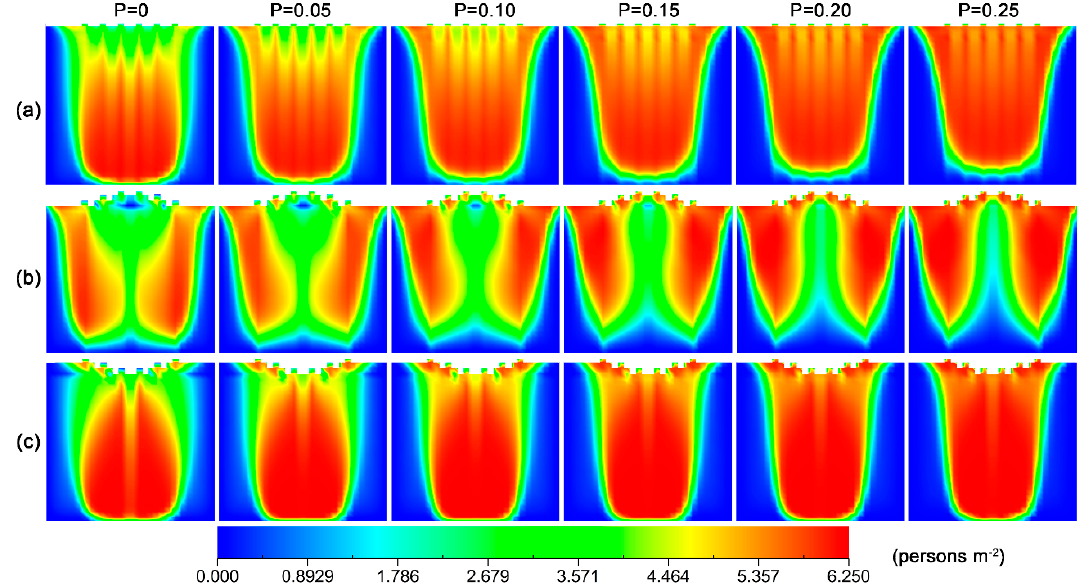
Figure 4. Density distribution of pedestrians in the scene at different checking failure probabilities for the three layouts of inspection points: ( a ) parallel, ( b ) convex and ( c ) concave. The density of pedestrian and delay are 3.5 persons/m 2 and 3 s, respectively. The unit of pedestrian density is persons/m 2 .